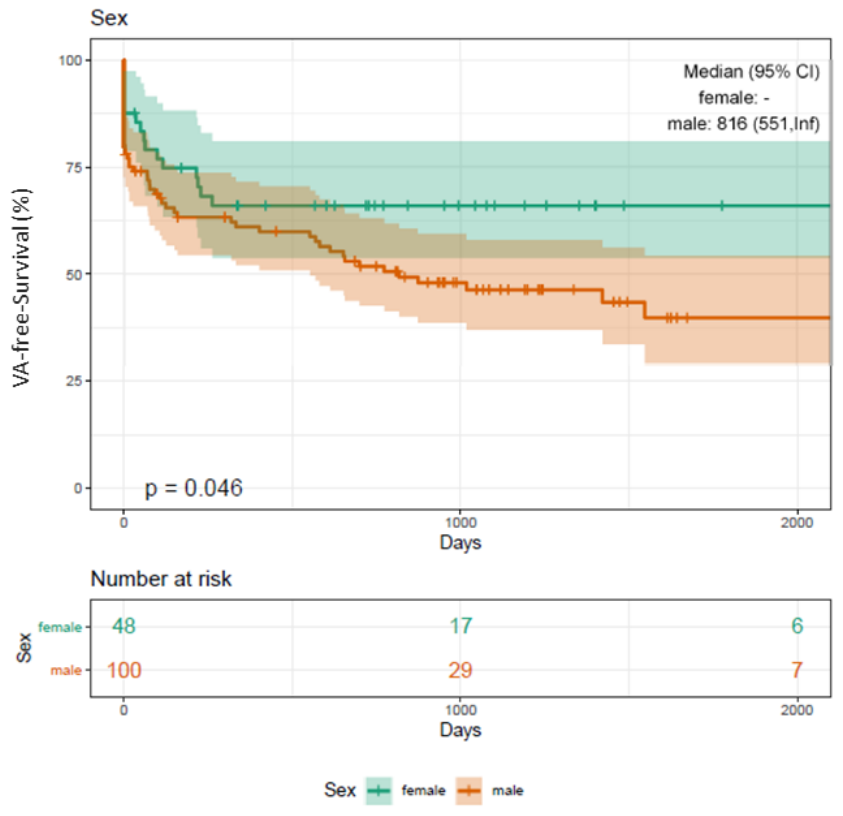
Figure 5. Kaplan–Meier plot on freedom from VA recurrence in patients undergoing RMN ablation depending on sex. Male patients undergoing RMN ablation for VA present with a significantly worse outcome compared to female patients (Log-rank p -value = 0.046*). VA, ventricular arrhythmia; VT, ventricular tachycardia; PVC, premature ventricular contractions; RMN, remote magnetic navigation; FU,